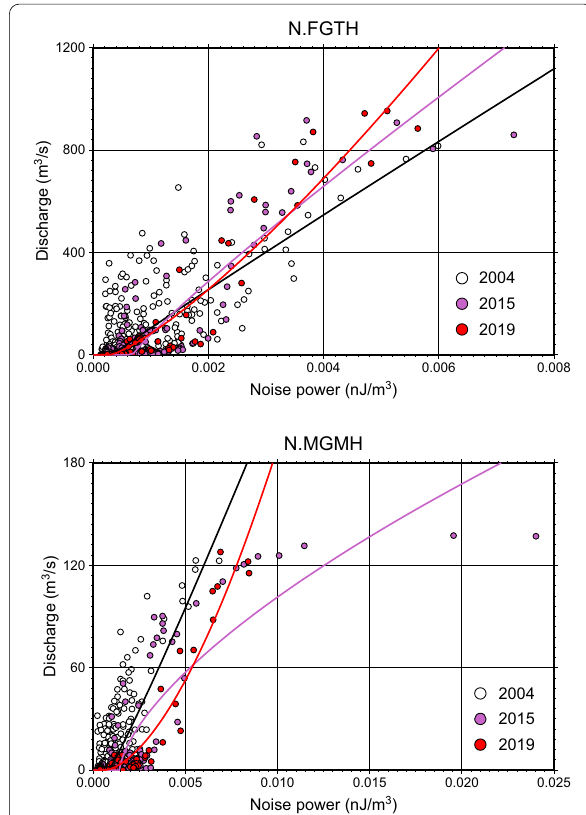
Fig. 7 Relationship between simulated discharge and seismic noise power data from the N.FGTH and N.MGMH stations for the events of July 2004, September 2015, and October 2019. Regression curves are estimated by fitting Eq. (3) to the data